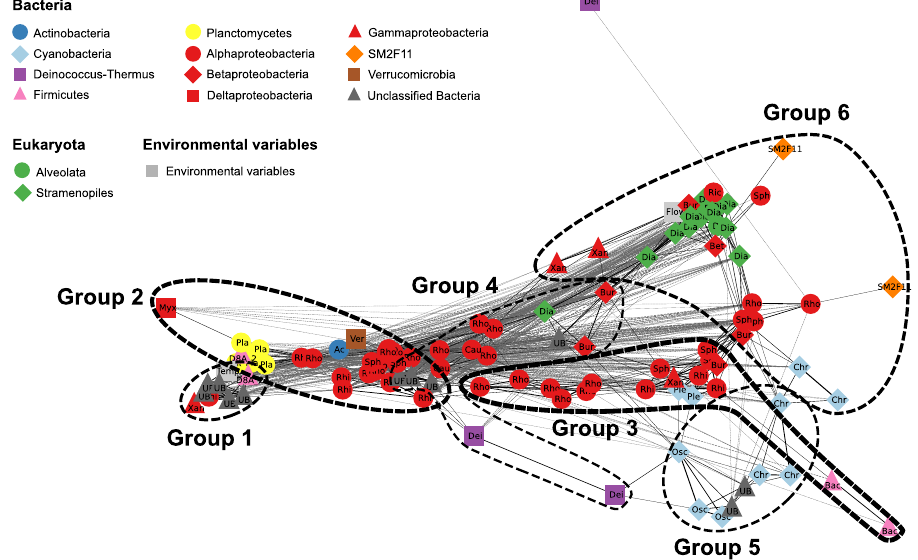
Figure 6. Network based on Spearman correlations among the relative abundances of the dominant bacterial and microeukaryotic OTUs and environmental data (water temperature at each sampling station and river water flow rate) for all the sampled biofilms. Only significant positive and negative correlations are represented (Spearman’s ρ > |0.5|). Nodes correspond to both microbial OTUs and environmental variables. Gray dashed and black solid lines represent negative and positive correlations, respectively. Line thickness is proportional to the value of correlations between two nodes; thick and thin lines correspond to high (near |1|) and low (near |0.5|) correlations, respectively. The six groups were defined using hierarchical clustering based on Spearman correlations generated using the hclust complete linkage method in R software. Abbreviations: Ac, Acidimicrobiales; Chr, Chroococcales; Osc, Oscillatoriales; Ple, Pleurocapsales; Dei, Deinococcales; Bac, Bacillales; Pla, Planctomycetales; Cau, Caulobacterales; Rhi, Rhizobiales; Rho, Rhodobacterales; Ric, Rickettsiales; Sph, Sphingomonadales; Bur, Burkholderiales; Myx, Myxococcales; Xan, Xanthomonadales; Ver, Verrucomicrobiales; UB, unclassified bacteria; Dino, Dinoflagellata; Dia, Diatomea; Flow, river water flow rate; Temp, water temperature at sampling